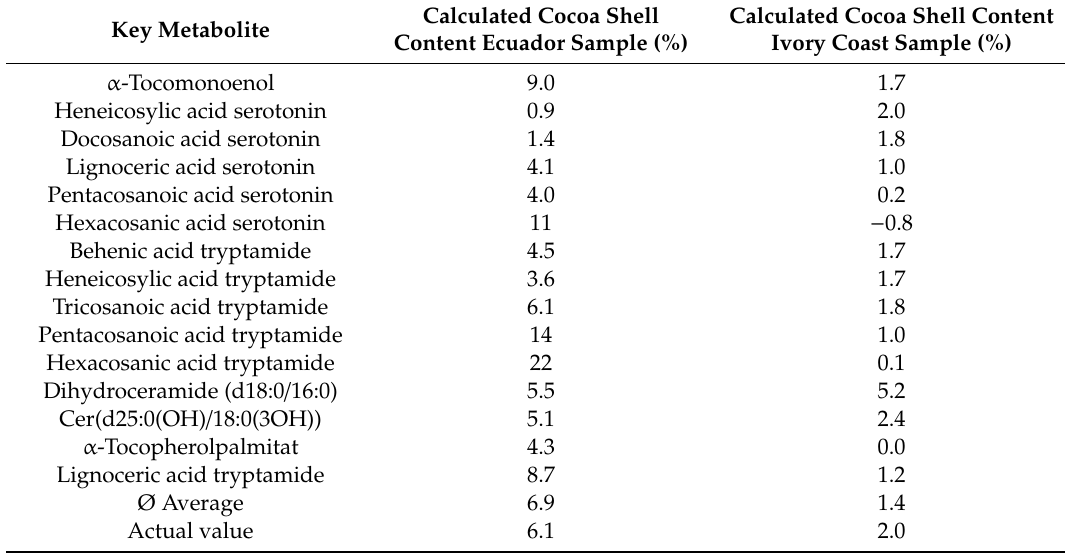
Table 3. Predicted cocoa shell content by linear regression of two di ff erent cocoa samples. Key